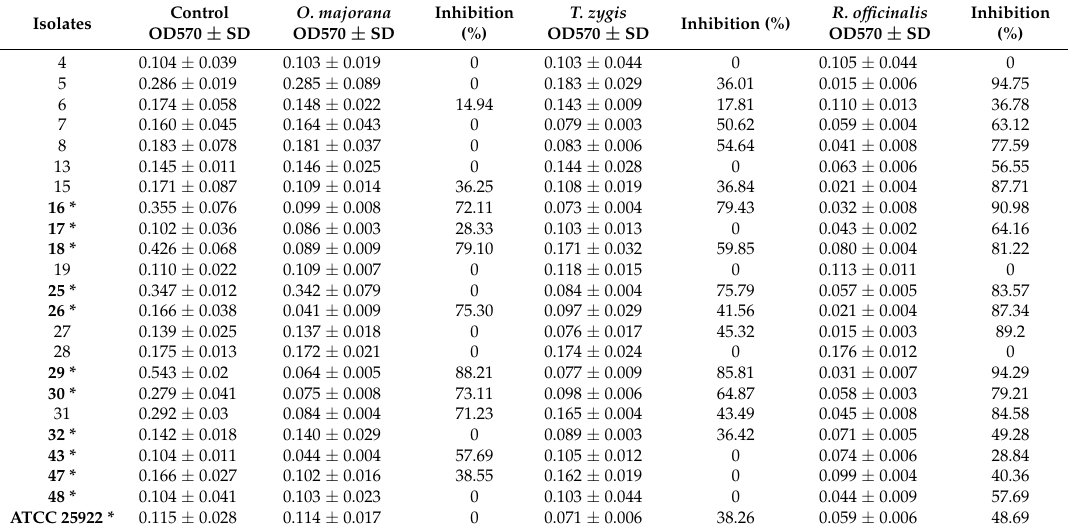
Table 5. Biofilm inhibitory activity of essential oils against E. coli